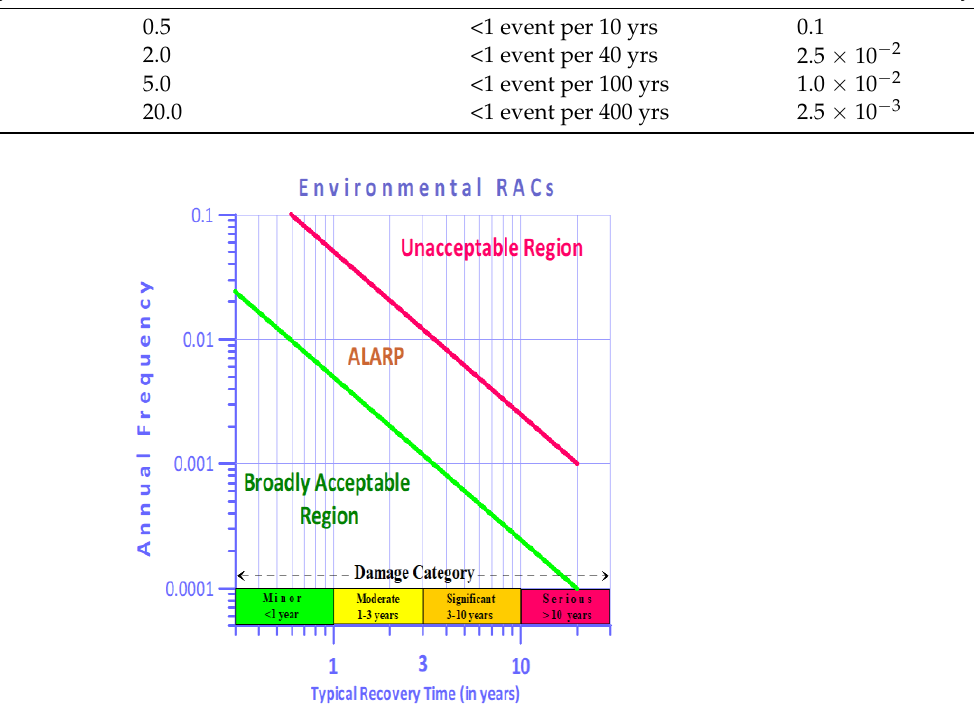
Figure 7. Environmental RACs (grounded on the work of Skjong et al., 2005) [46]. Table 3. Cost-benefit RACs concerning different industries (grounded on the paper of Spouge et al., 2015) [33].